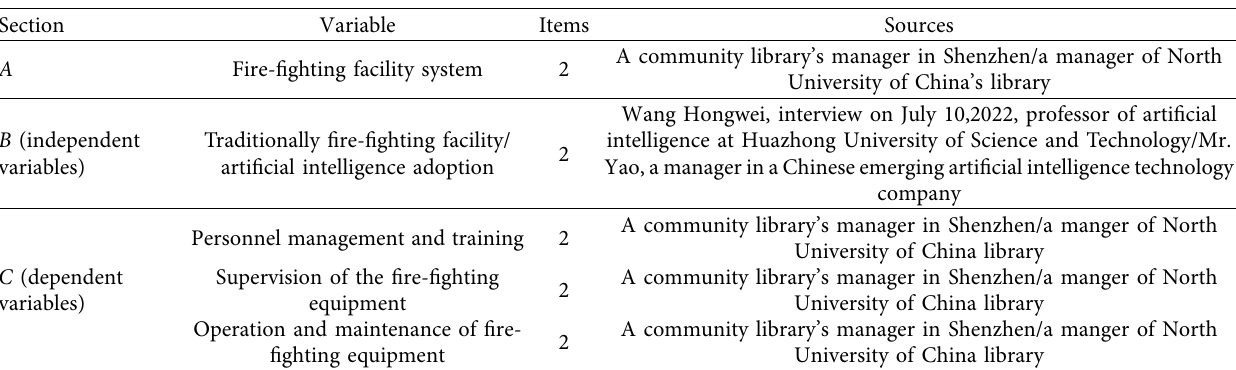
Table 6: Interview design